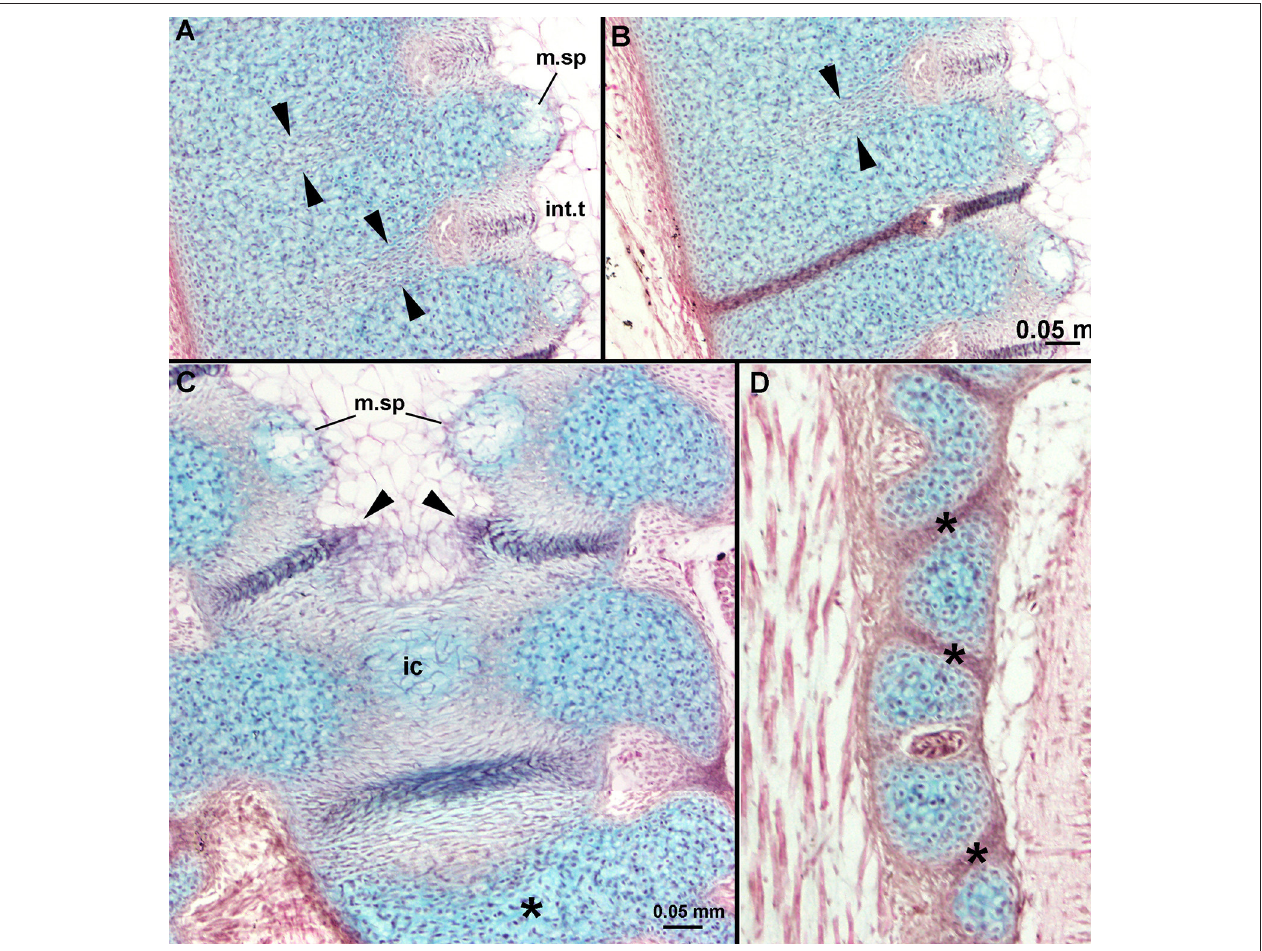
FIGURE 7 | Leucoraja erinacea , st. 31, horizontal histological sections, stained with alcian blue, haematoxylin and eosin. (A,B) Showing developing intervertebral tissue, along with aligned and differentiating cells extending from developing intervertebral tissue to lateral margin of the cartilage (between black arrowheads), these staining with haemotoxylin more posteriorly (B) ; (C) more posteriorly along central vertebral axis, showing developing internal cartilage (ic), resulting from midline fusion of medial spaces filled with mesenchymal cells. More posteriorly, extracellular matrix (staining blue) is being deposited (asterisk); (D) separation of vertebral elements (asterisks) from originally continous cartilage sheath. Abbreviations as in previous figures, also, ic, internal layer of cartilage. Scale bars: (B,C) =